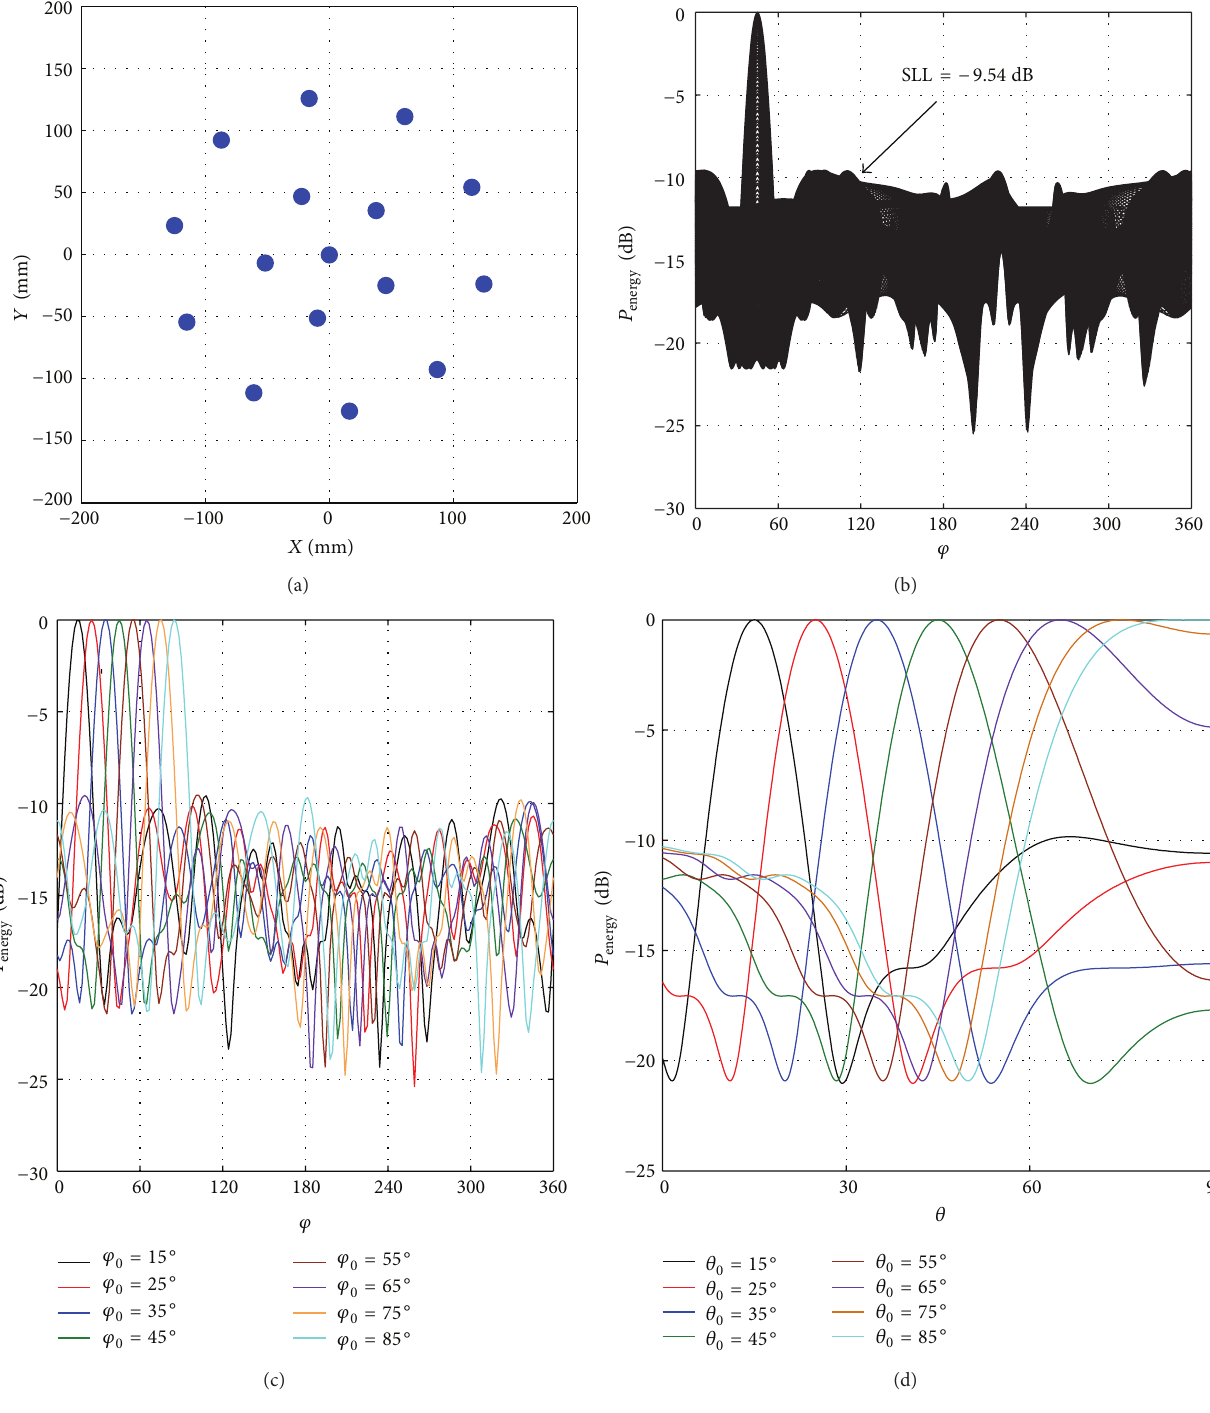
Figure 5: Result of RNUCRA: (a) antenna and delay distributions, (b) SEP in 𝜃 0 = 𝜑 0 = 45 ∘ , (c) azimuth cuts with 𝜃 0 = 45 ∘ , and (d) elevation cuts with 𝜑 0 = 45 ∘